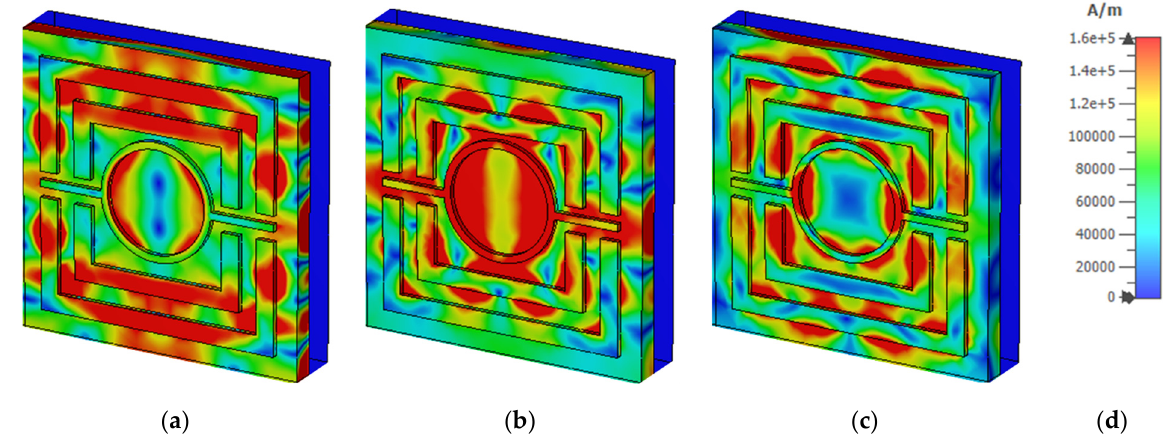
Figure 14. H-field distribution at ( a ) 450 nm ( b ) 557 nm ( c ) 650 nm ( d ) A/m scale.